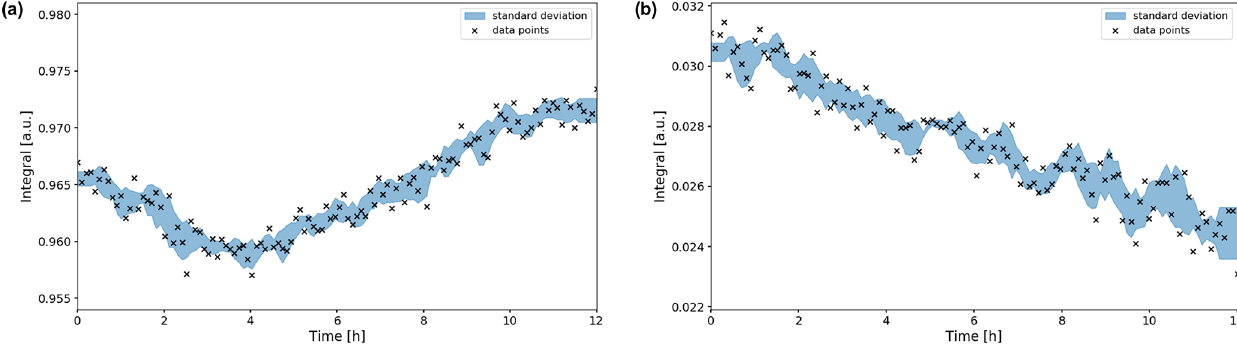
signal fluctuates within the 1% range, 3